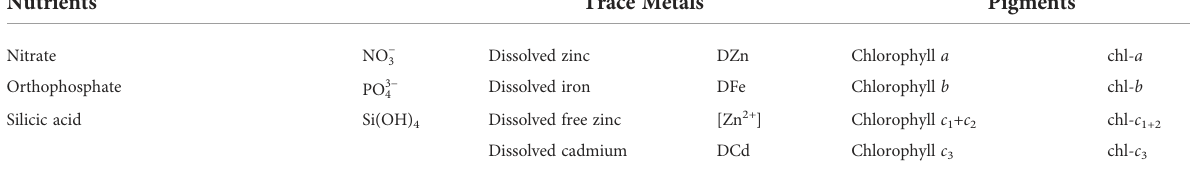
TABLE 1A Summary of biological and chemical measurements taken daily from T 0 samples and on-deck incubations at Ocean Station Papa (OSP) in June 2001.